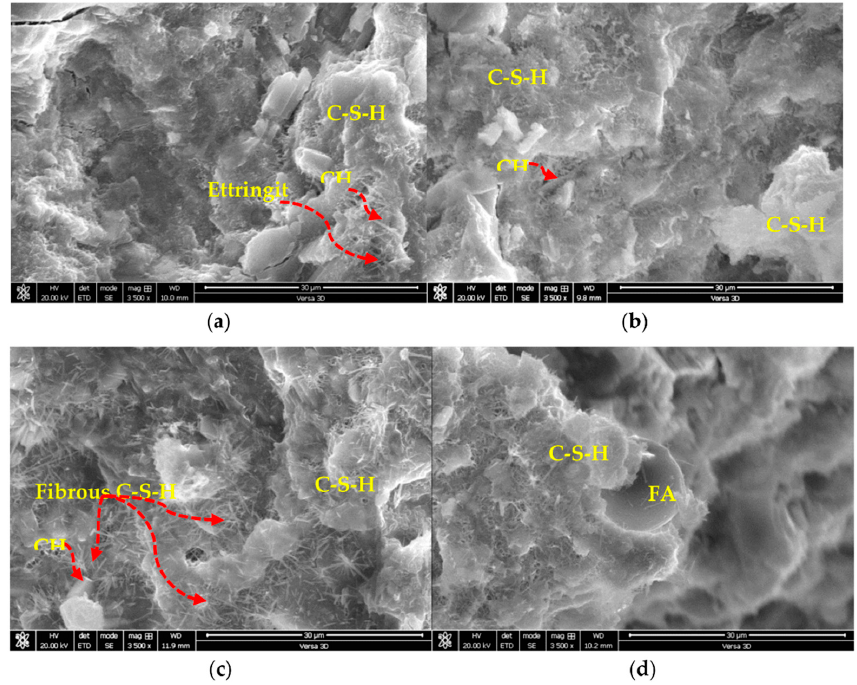
Figure 20. SEM images of concrete mixes ( a ) CTRL, ( b ) NP1, ( c ) NP2 and ( d ) FA